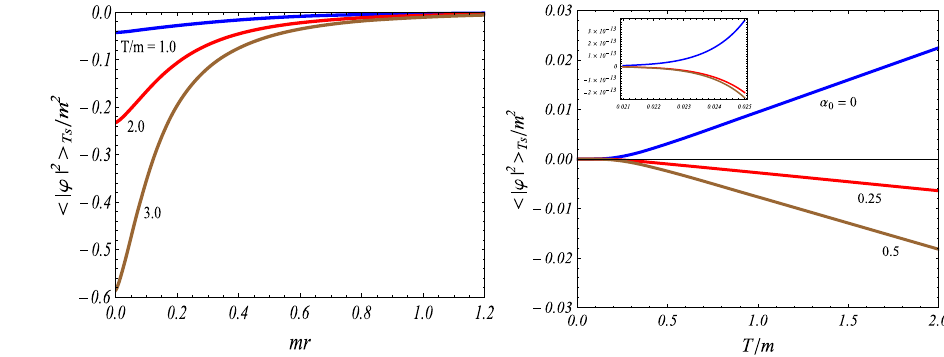
which goes to zero in the limit L → ∞